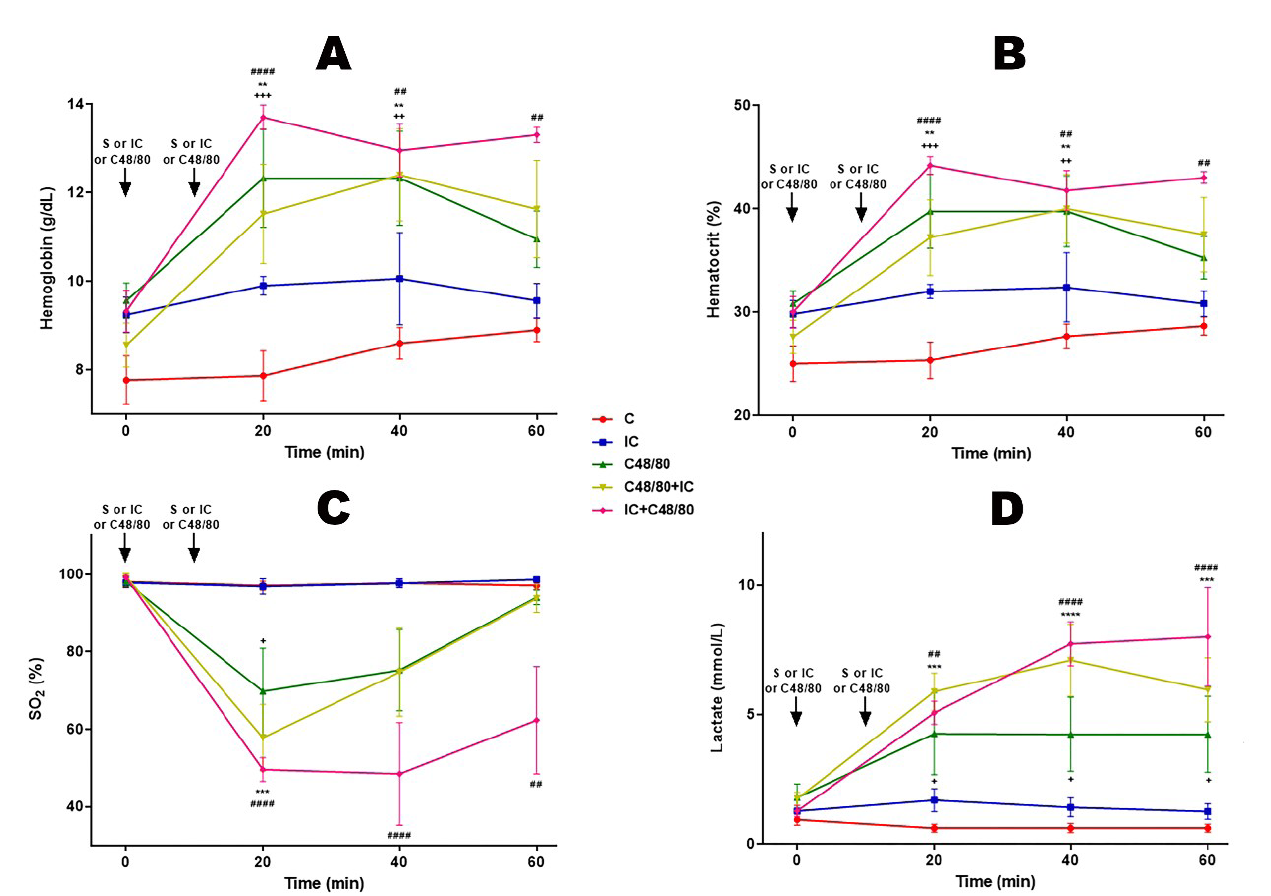
Fig. 5 - Hemoglobin, hematocrit, oxygen saturation and lactate. Effect of anaphylactic shock caused by compound 48/80 (C48/80) and treated with indigo carmine (IC) in pigs. A) Hemoglobin; B) Hematocrit; C) Oxygen saturation (SO2); D) Lactate. At minute 0, the control (C) group received saline (S), the C48/80 and C48/80+IC groups received C48/80, the IC and IC+C48/80 groups received IC. At minute 10, the C, IC and C48/80 groups received S, the C48/80+IC group received IC and the IC+C48/80 group received C48/80. Data represent means ± standard error of mean and analyzed by two-way analysis of variance (ANOVA), Dunnett post-test (n=5). + P<0,05; */++/## P<0,01; +++/* P<0,001; **/#### P<0,0001 ( C vs. C48/80+IC; + C vs. C48/80; # C vs.